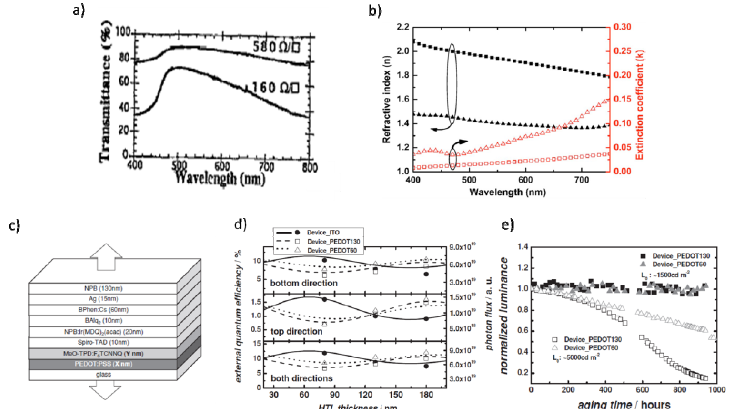
Figure 4. ( a ) Transmittance and sheet resistance of different polyaniline (PANI) thicknesses [34]; ( b ) the wavelength dependence of the refractive index and the extinction coefficient of ITO (squares) and PANI (triangles) films [35]; ( c ) the device structure of ITO-free transparent OLEDs based on a PEDOT:PSS TCE; ( d ) the comparison of external quantum efficiencies (EQEs) and corresponding photon fluxes for bottom and top emission and the sum of both (experiment (symbols) and optical simulation (lines) results); ( e ) aging characteristics of PEDOT:PSS-based OLEDs with a different PEDOT:PSS thickness. The encapsulated devices are aged over around 900 hours with an initial luminance of around 1500 cd/m 2 . Constant currents are applied for each sample according to the corresponding luminance [47]. HTL, hole transport